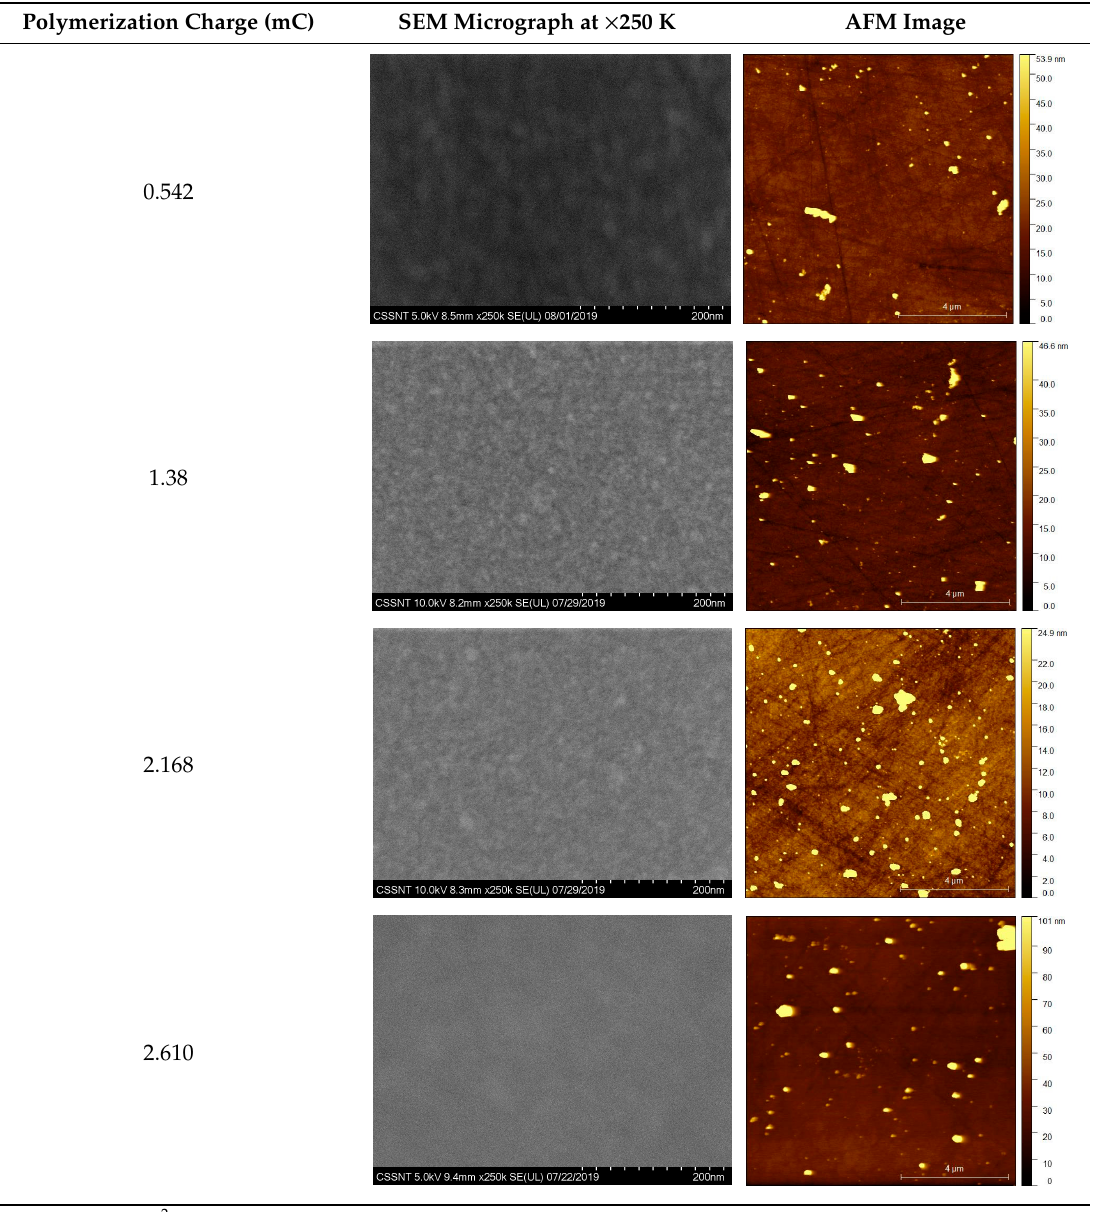
Table 3. SEM at x250K and AFM micrographs for films obtained by CPE at 1 V with different polymerization charges 2 .